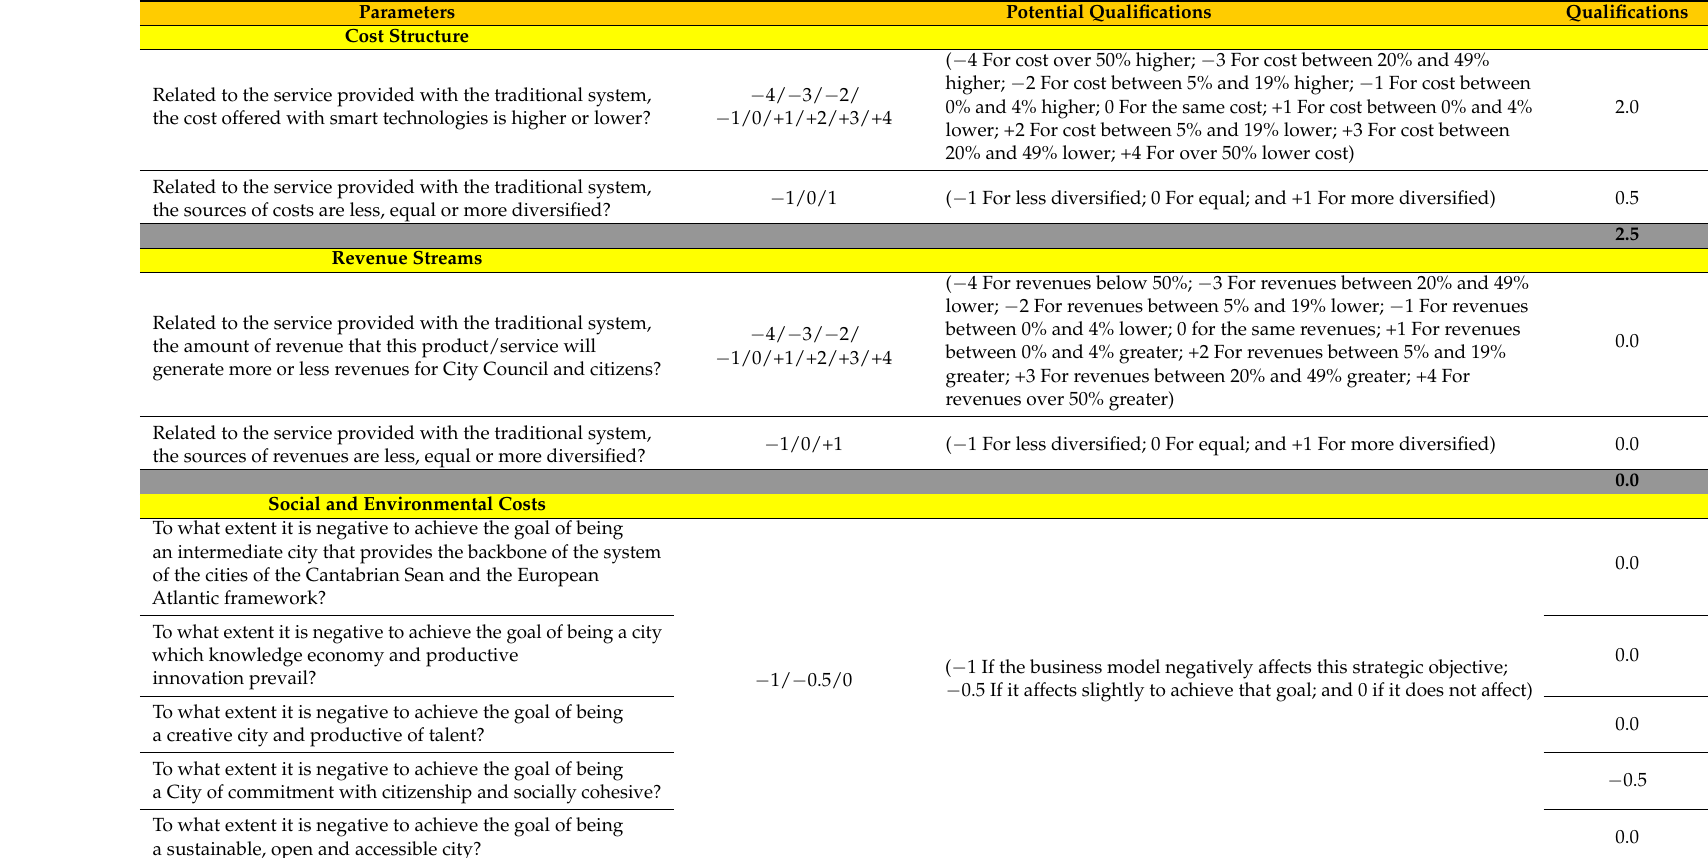
Table 4. Business Model Evaluation Tool linked to the Santander’s Waste Management